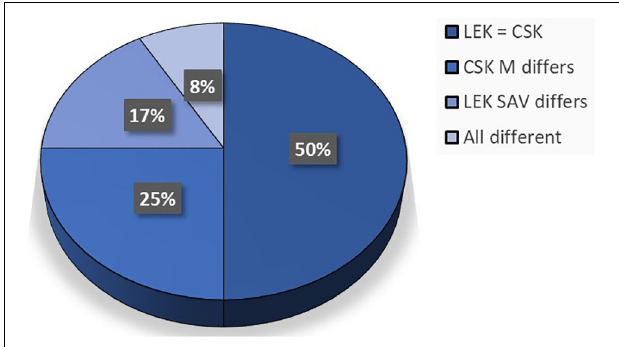
FIGURE 4 | Pie chart depicting the relation between LEK and CSK regarding fish habitat use. The habitats that are used by different species of fish data obtained from scientific literature (CSK) (Berkström et al., 2012; Tano et al., 2017) compared with that obtained from interviewing local fishers (LEK) in Zanzibar, Tanzania. Fishers were shown pictures of different fish species and different habitats, and were asked to point to habitats that each individual fish species were found in. C, corals; SAV, submerged aquatic vegetation; M, mangroves. “CSK M” refers to scientific data regarding the mangrove habitat, “LEK SAV” refers to local fisher’s data regarding the SAV habitat. “All different” means that more than one LEK habitat did not match the CSK habitats.